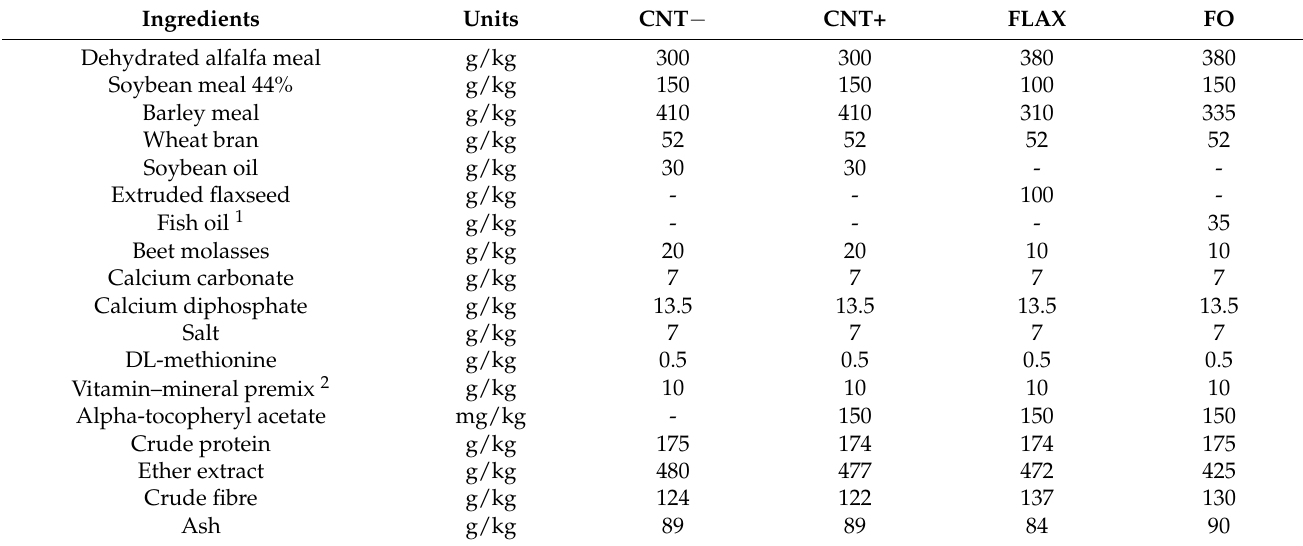
Table 1. Formulation and proximate analysis of the control and n-3 polyunsaturated fatty acid (PUFA)-enriched diets.